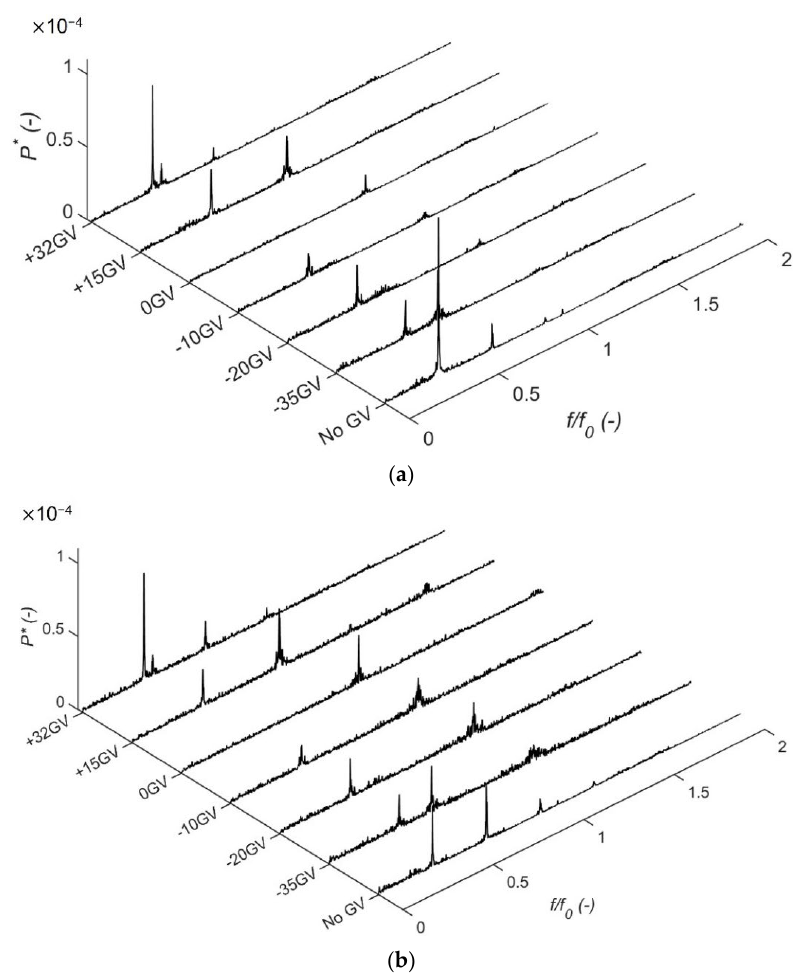
Figure 6. Normalized pressure signal FFTs for PL1 operating conditions without and with the GV system at ( a ) DT1 sensor at L1 and ( b ) DT4 sensor at L2. Table 6. RVR frequency shift in the presence of GV system at PL1 and